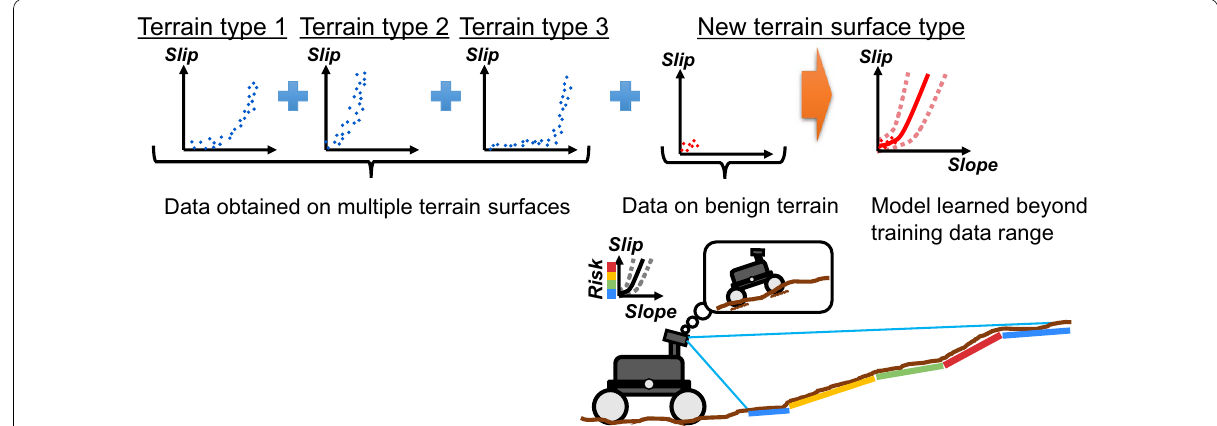
Fig. 1 Concept of proposed traversability prediction based on multi-source transfer regression. By leveraging past experiences on multiple terrain surfaces, the proposed method improves the prediction accuracy on possibly risky terrains only from traverse data on safer terrains in new environments